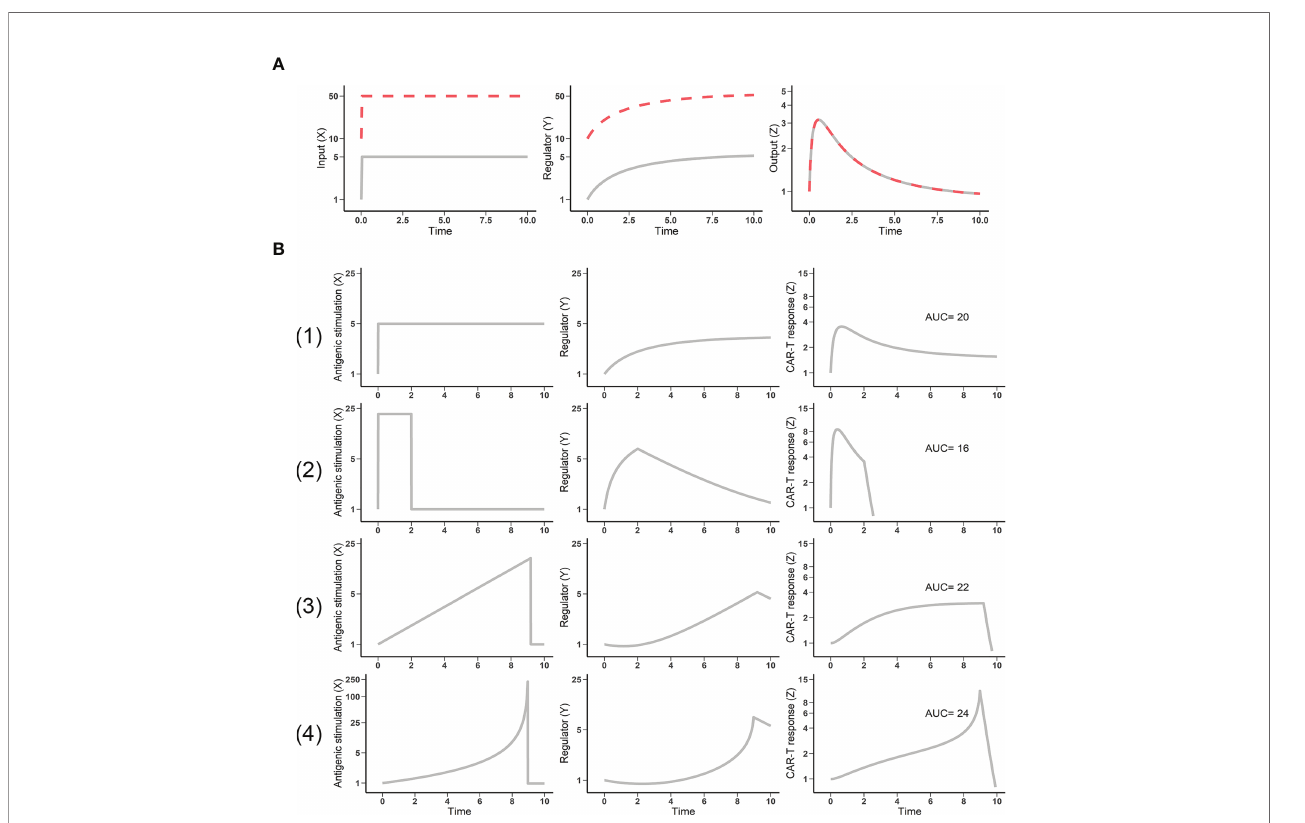
FIGURE 2 | Fold-change detection in the incoherent feedforward loop (IFFL) reveals the impact of antigen presentation dynamics. (A) IFFL provides fold-change detection. Two inputs (gray and dashed red lines) of the same fold-change yield identical outputs, despite different baselines. (B) Antigen stimulus dynamics in fl uences CAR-T cell response. Four patterns of antigen stimulus with equivalent area under the curve (AUC) were explored. (1) Constant appearance; (2) high but transient appearance; (3) linear appearance; and (4) exponential appearance of antigen (input X) yielded responses (output Z) with diverse amplitude, duration, and cumulative strength (AUC) pro fi